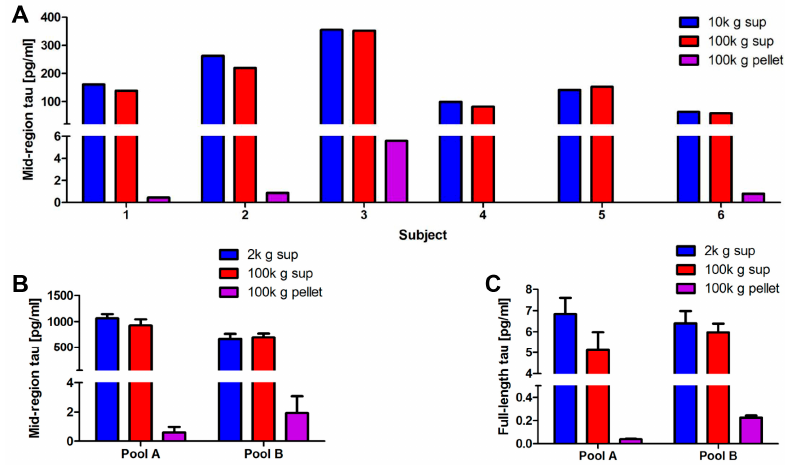
Figure 4. Exosomes from human CSF contain detectable amounts of full-length, aggregation-competent tau. ( A ) CSF samples from six healthy controls were processed by serial centrifugation, as described in Figure 3A. Free tau was measured in CSF in 10,000 g supernatant (blue) 100,000 g supernatant (red), and the 100,000 g pellet (purple). The majority of tau is free-floating, while a small amount of tau is recovered in the exosomal pellet of 4 out of 6 samples. Values represent the mean of technical replicates. ( B , C ) Two pools of CSF, designated Pool A and Pool B, were processed as above and the 2,000 g supernatants (blue) 100,000 g supernatants (red), and 100,000 g pellets (purple) analyzed using our mid-region ELISA ( B ) and FL Simoa assay ( C ). Concentrations represent the amount of analyte present in 1 mL of starting cerebrospinal fluid (CSF) and are corrected to account for dilutions incurred during the various processing steps. Results in ( A ) represent the mean of two technical replicates, and results in ( B , C ) indicate the mean ± SD of technical replicates of two independent experiments.